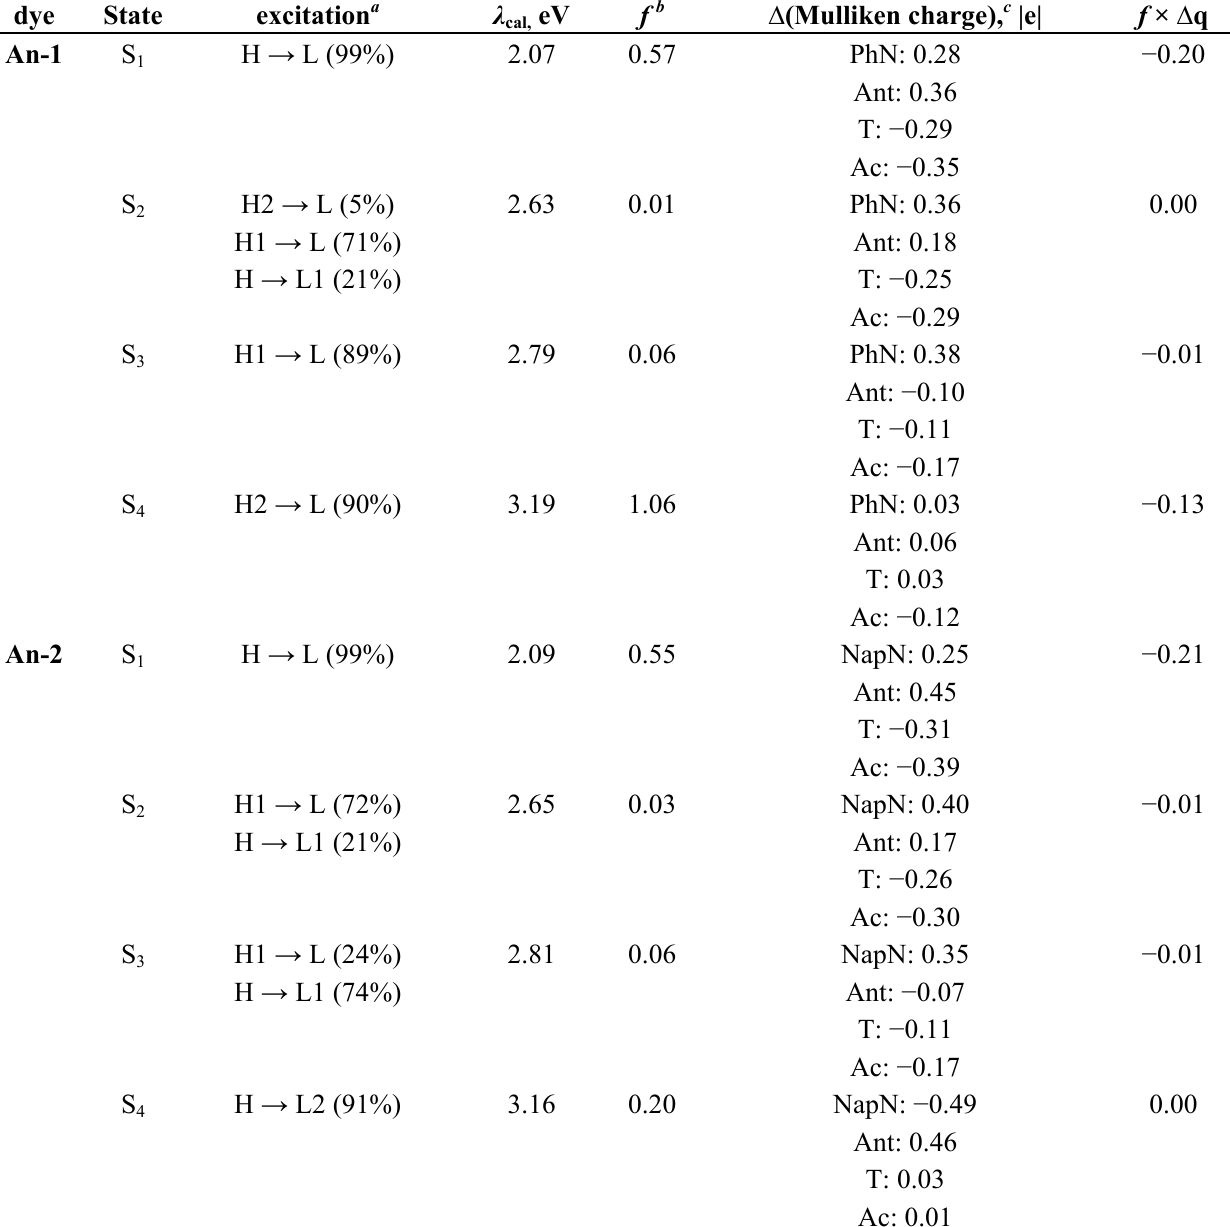
Table 3. Calculated lower-lying transitions of the dyes.